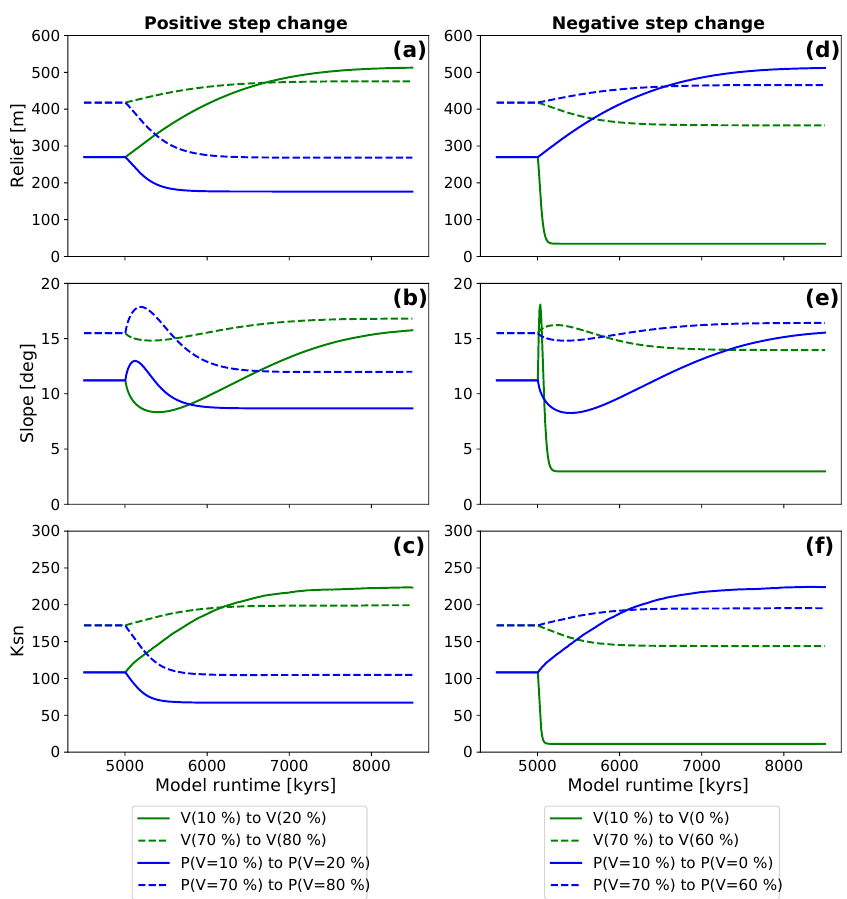
Figure 8. Observed evolution of topographic metrics after a step change in either vegetation (green lines) or mean annual precipitation (blue lines). Results are shown for two different initial vegetation cover amounts of V = 10 and 70%. Imposed mean annual precipitation changes were undertaken by selecting the precipitation amount corresponding to the initial and final vegetation amounts used in the simulations for vegetation cover “only” change. Panels (a) , (b) , and (c) show the reaction of model topographies to positive changes in boundary conditions. Panels (d) , (e) , and (f) show the reaction to negative changes in boundary